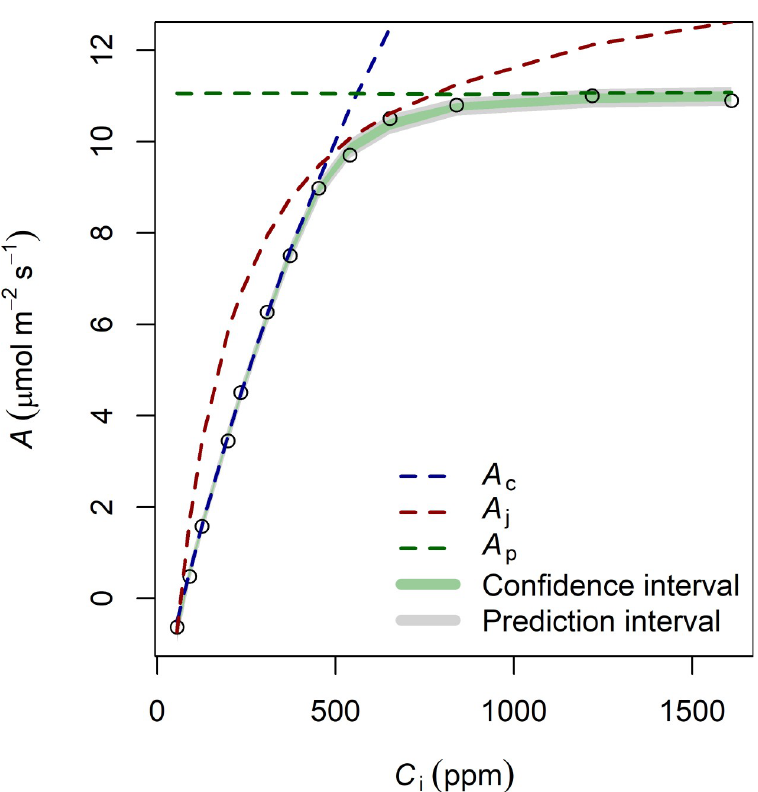
Fig 1. Example of fitting of an A-C curve. The observations are represented by points. The Rubisco carboxylation i rate ( A c ), the electron transport rate ( A j ) and the triose phosphate utilization rate ( A p ) of net photosynthesis are shown. The three limiting rates of photosynthesis ( A c , A j and A p ) depend on the parameters V cmax25 , J max25 and T p25 , respectively. The confidence interval of the mean A is shown in green (i.e., the 95% interval where the mean A is expected) as well as the interval of prediction in grey (i.e., the 95% interval where a measure of A should fall).